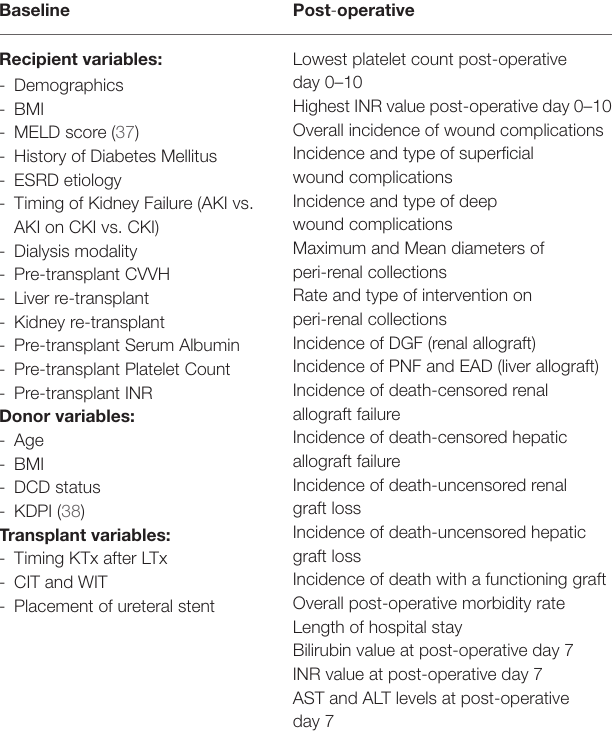
TABLE 1 | Variables analyzed.